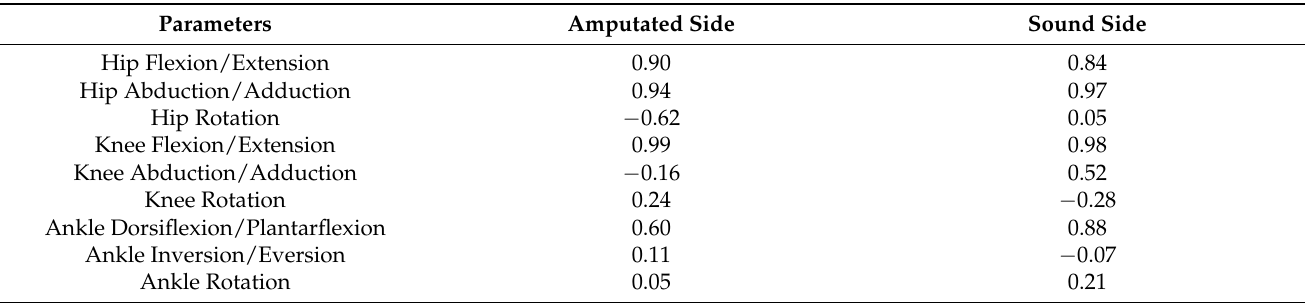
Table 3. Between-protocol intraclass correlation coefficients (ICC) for lower limb measures during the gait